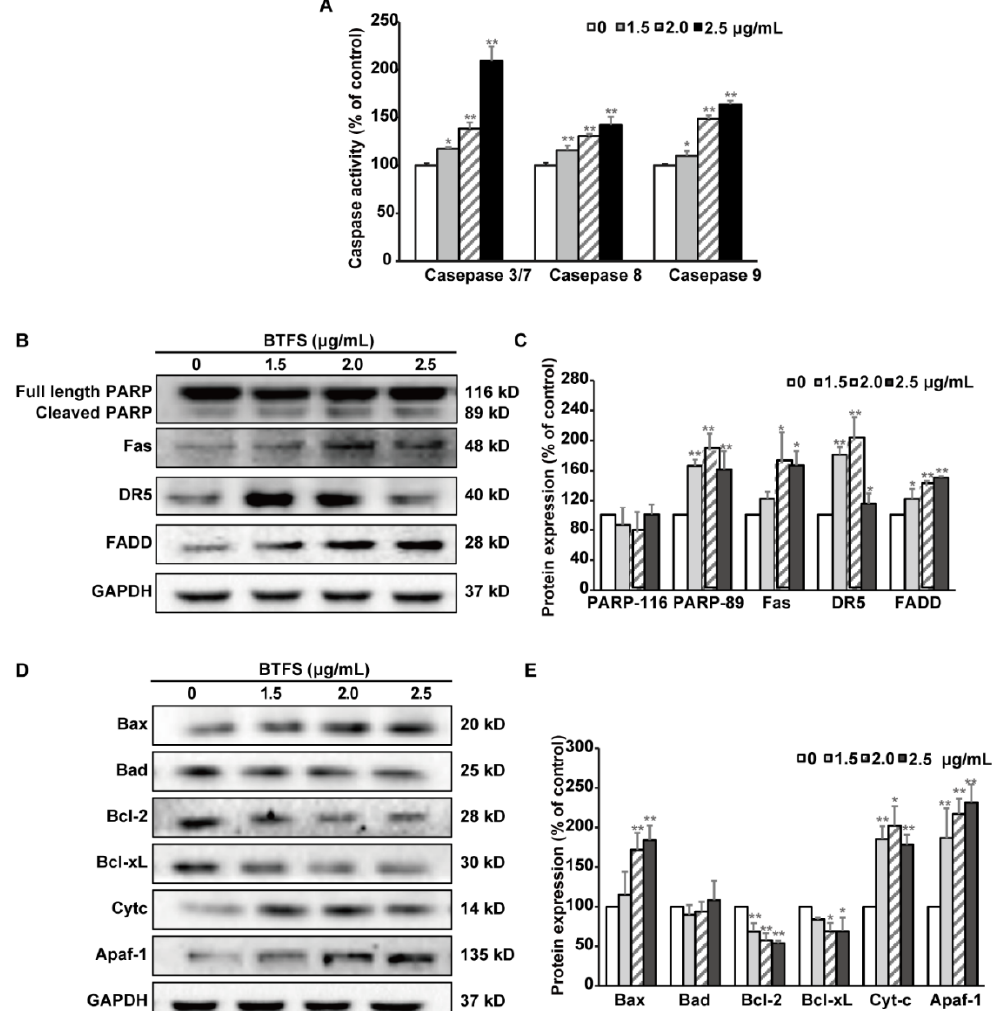
Figure 5. BTFS trigged both extrinsic and intrinsic pathways. ( A ) Effects of BTFS on the activity of caspase-3 / 7, 8 and 9. * p < 0.05 and ** p < 0.01 versus control. ( B , C ) Effects of BTFS on extrinsic apoptosis- related protein expression in A2780 / CP70 cells. ( D , E ) Effect of BTFS on intrinsic apoptosis-related protein expression in A2780 / CP70